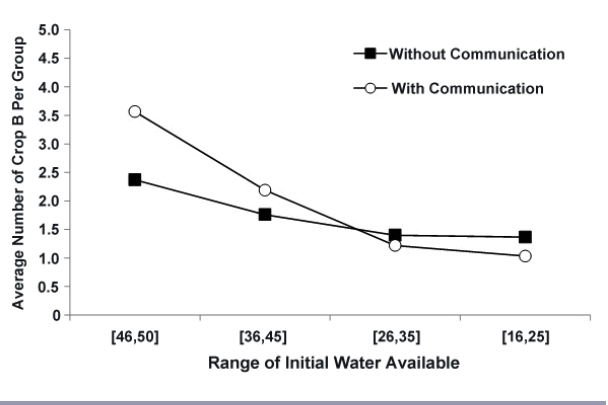
Fig. 4. Average number of Crop B (intensive water use) per group for different levels of ground water available, in games without participant communication and with communication after each